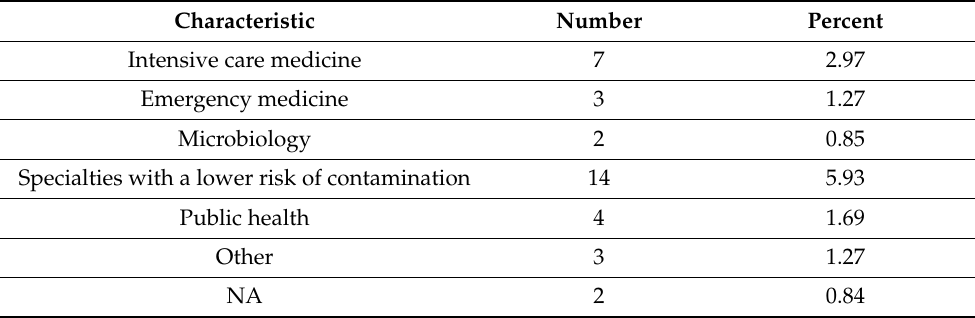
Table 4. Personal preference for a new residency specialization.